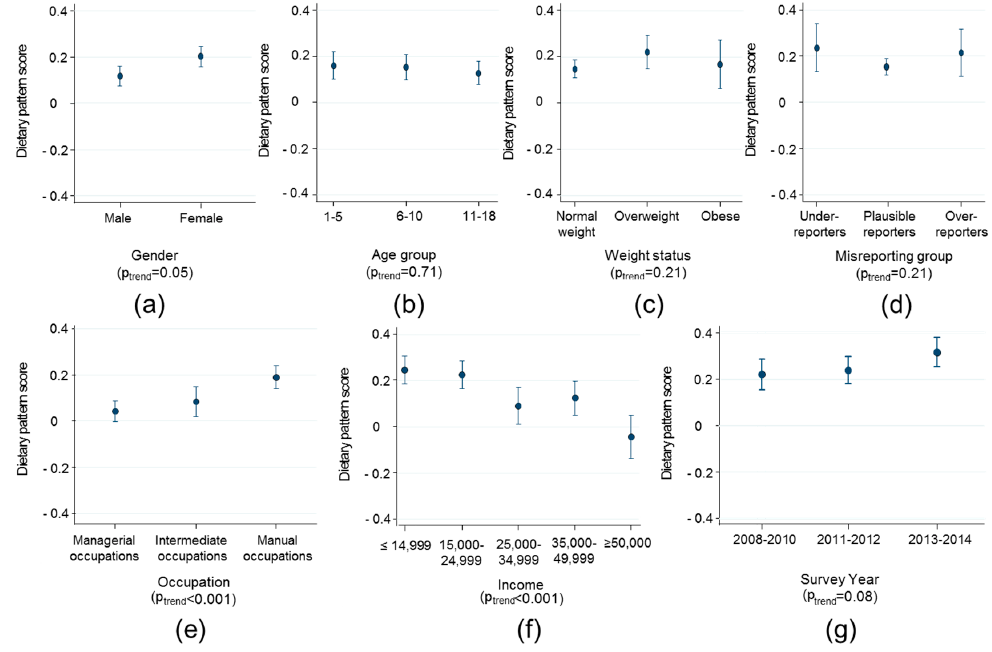
Figure 2. Trends in the obesogenic dietary pattern score among children (<18 years) by ( a ) sex; ( b ) age; ( c ) weight status; ( d ) energy reporting status; ( e ) occupation; ( f ) household income; and ( g ) survey